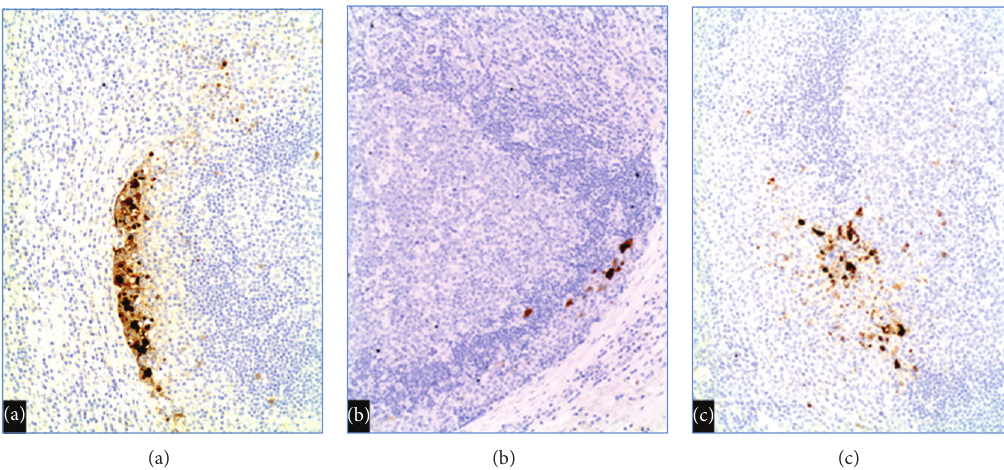
Figure 2: Immunohistochemical stains show small numbers of HSV-I/HSV-II positive cells in (a) subcapsular sinus (Case 2) 40x magnification, (b) subcapsular sinus (Case 1) 100x magnification, and (c) areas of monocytoid B-cell hyperplasia (Case 2) 100x magnification.